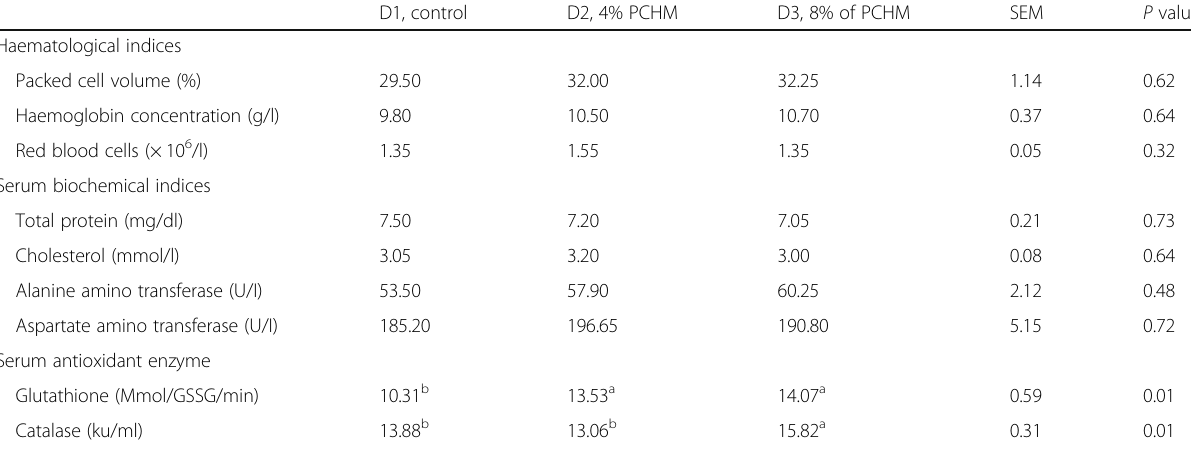
Table 6 Effects of processed cocoa pod meal (PCHM) on erythrogram